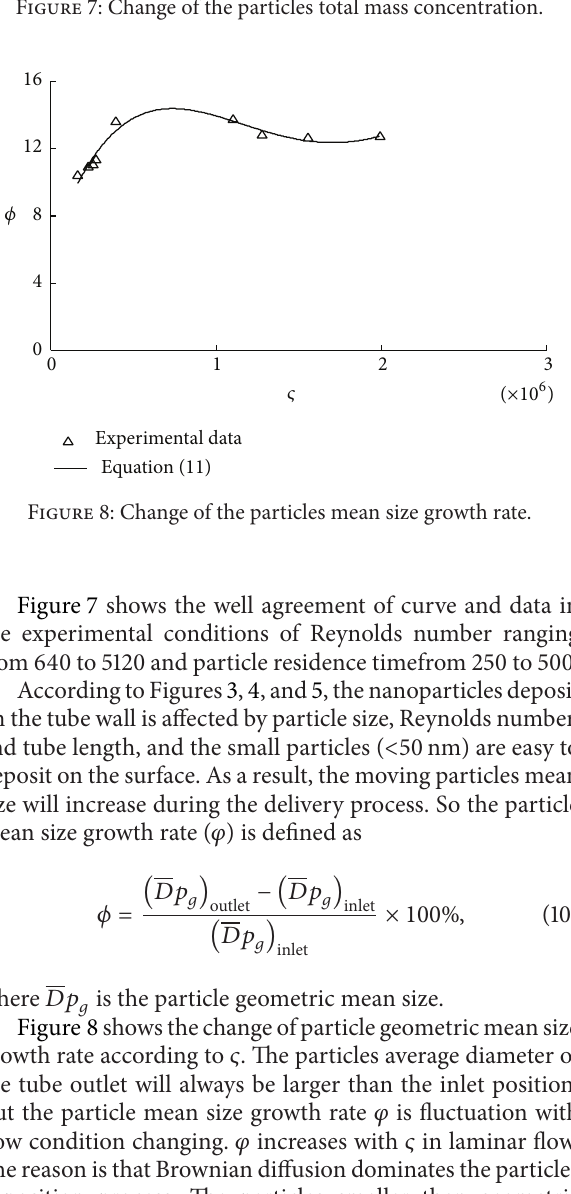
Figure 7: Change of the particles total mass concentration.